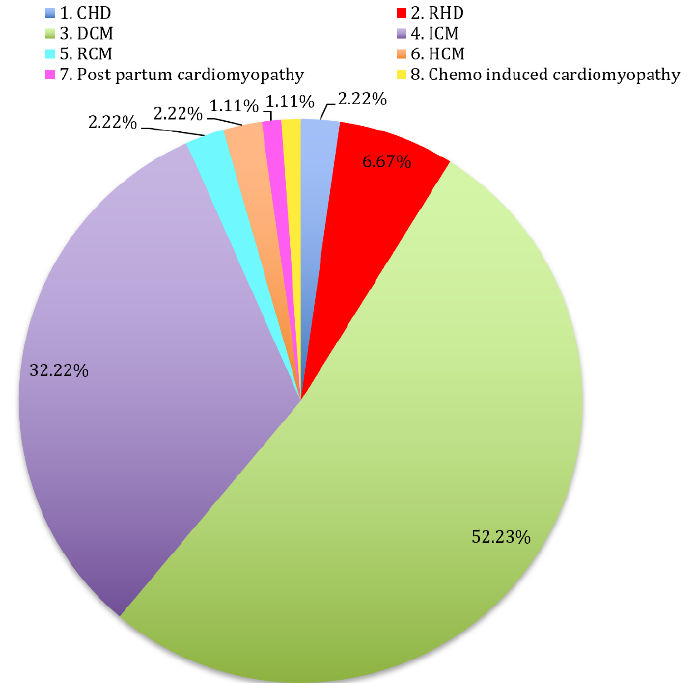
Figure 3. Percentages of main pre-transplant diagnoses among study recipients. (CHD: congenital heart disease, RHD: rheumatoid heart disease, DCM: dilated cardiomyopathy, ICM: ischemic cardiomyopathy, RCM: restrictive cardiomyopathy, HCM: hypertrophic cardiomyopathy).